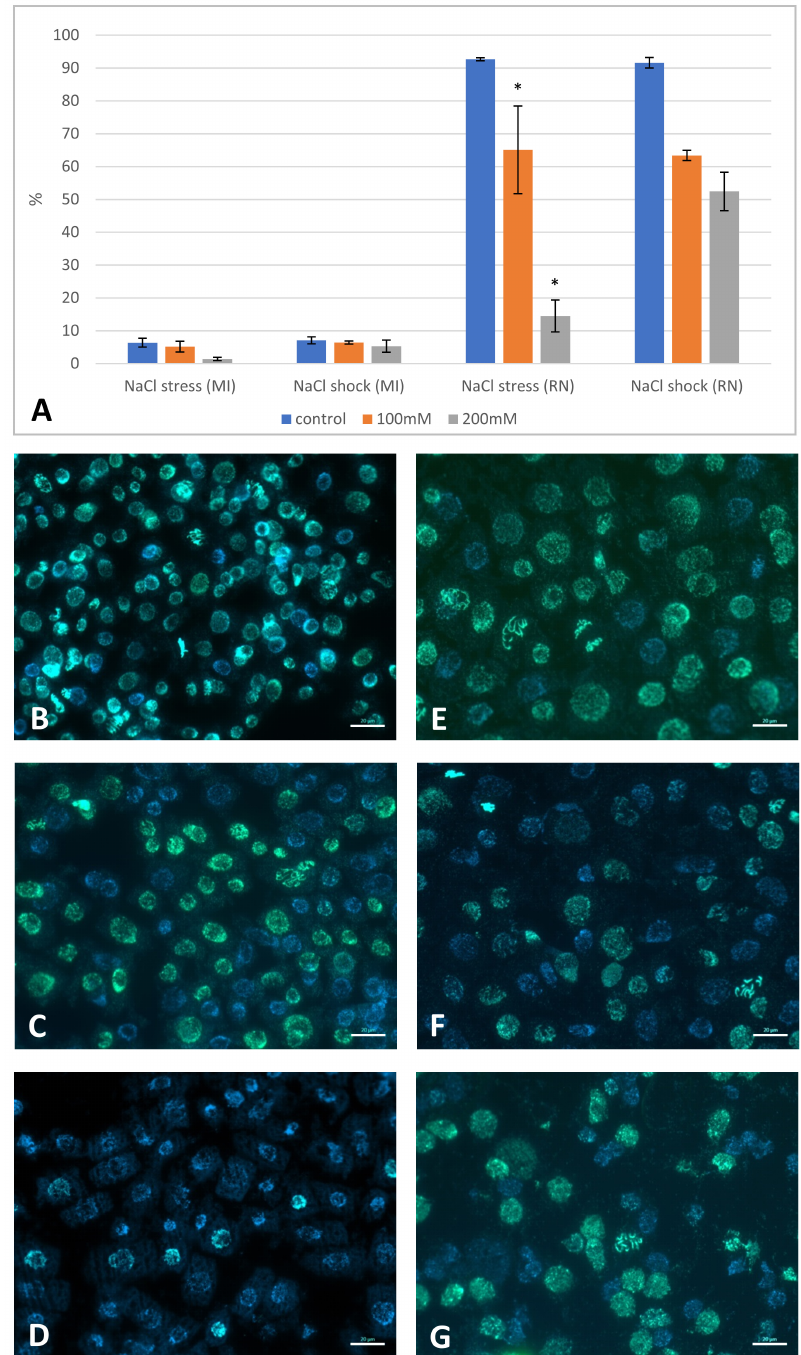
Figure 6. Mitotic activity of the root cells in “salt-stressed” and “salt-shocked” Brachypodium seedlings and the frequency of nuclei with replicated DNA in the root meristematic cells. ( A ) Mitotic index (MI) and the percentage of replicated nuclei (RN) after “salt-stress” and “salt-shock”, which were caused by applying various concentrations of NaCl. Asterisks indicate significant differences from the control; differences between the groups were calculated using the one-way ANOVA ( p < 0.05; mean ± SD, n = 3) with a prior arcsine square root transformation. ( B – G ) Detecting the EdU (green fluorescence) that had been incorporated into the actively replicating nuclei in the “salt-stressed” ( B – D ) and “salt-shocked” ( E – G ) Brachypodium seedlings. ( B , E ) control, ( C , F ) 100 mM NaCl, ( D , G ) 200 mM NaCl. Blue colour—DAPI fluorescence; green colour—Alexa Fluor 488 fluorescence. Scale bars represent 20 µm.